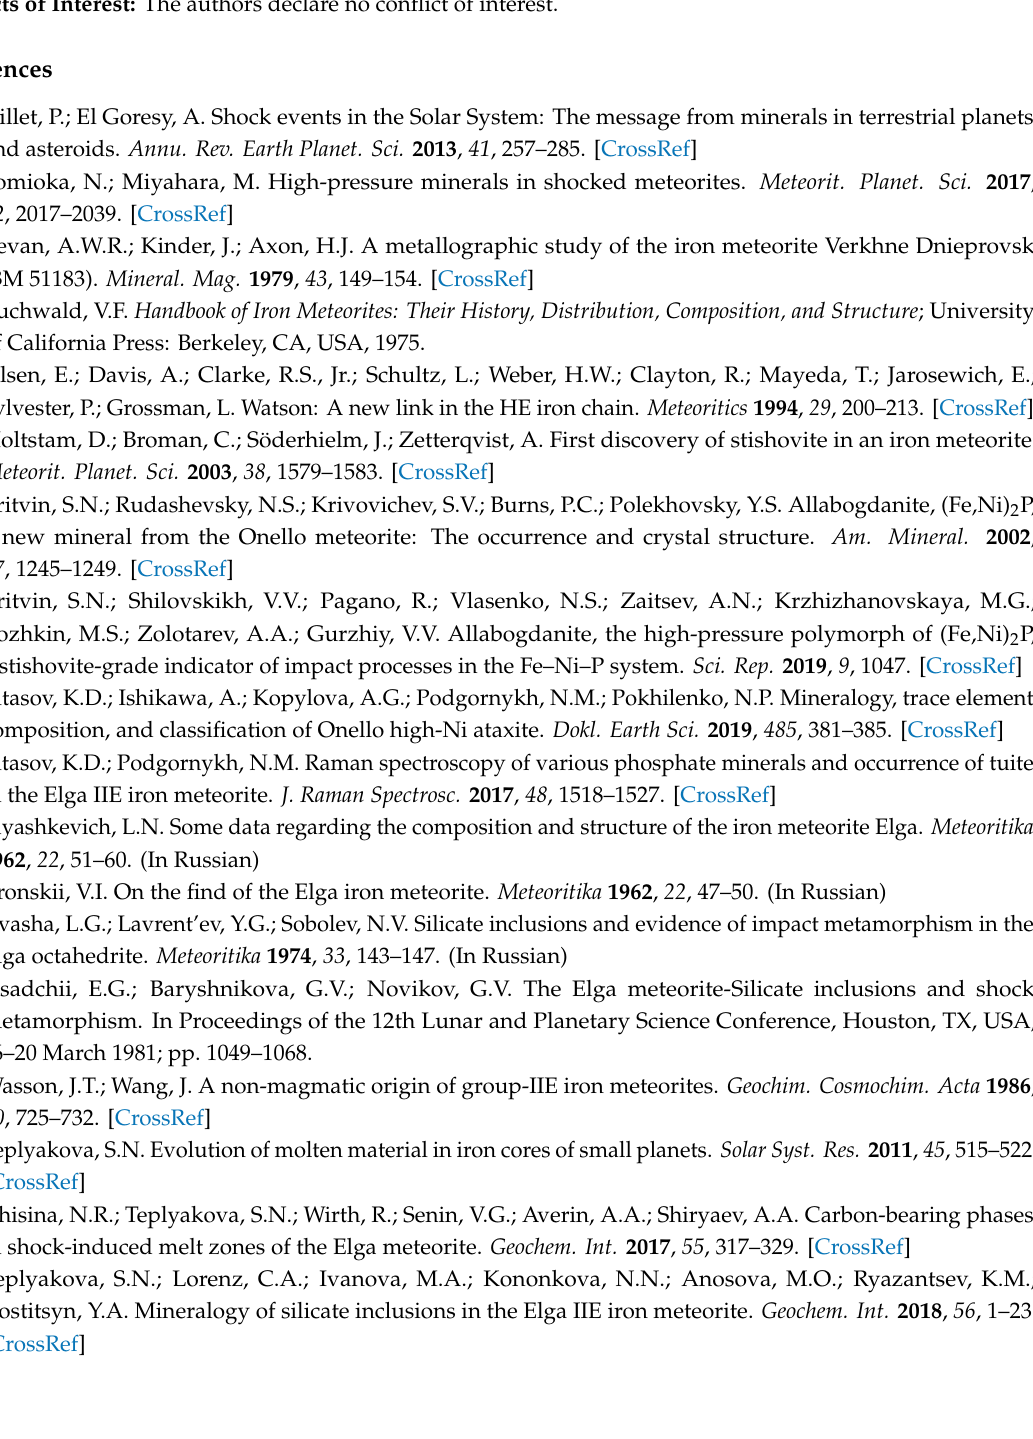
Table S1: Representative compositions (wt %) of Fe–Ni–P–S aggregates from the Elga IIE iron meteorite. Table S2: Table S3: Detailed analyses (wt %) of Fe–Ni–P–S S dendritic aggregates subjected to oxidation or mixed with oxidized